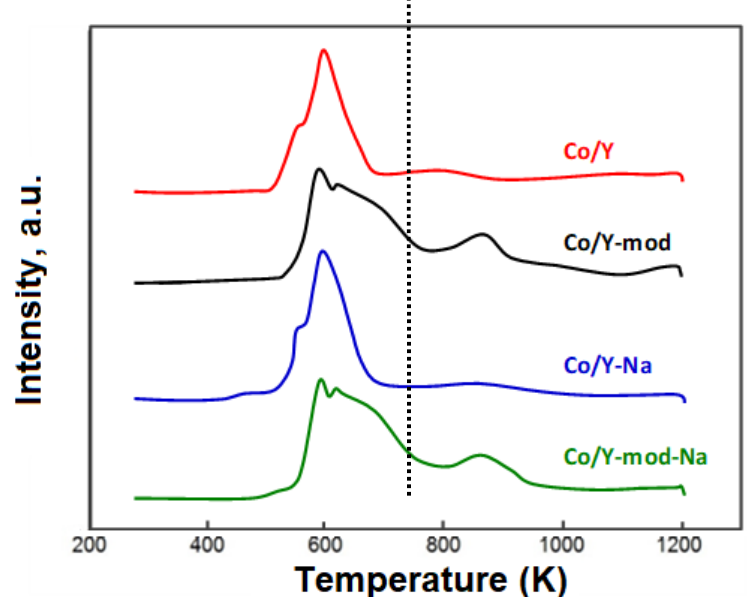
Figure 6. Temperature-programmed reduction (TPR) of calcined catalysts. (—) Reduction temperature of the catalysts before reaction (873 K).